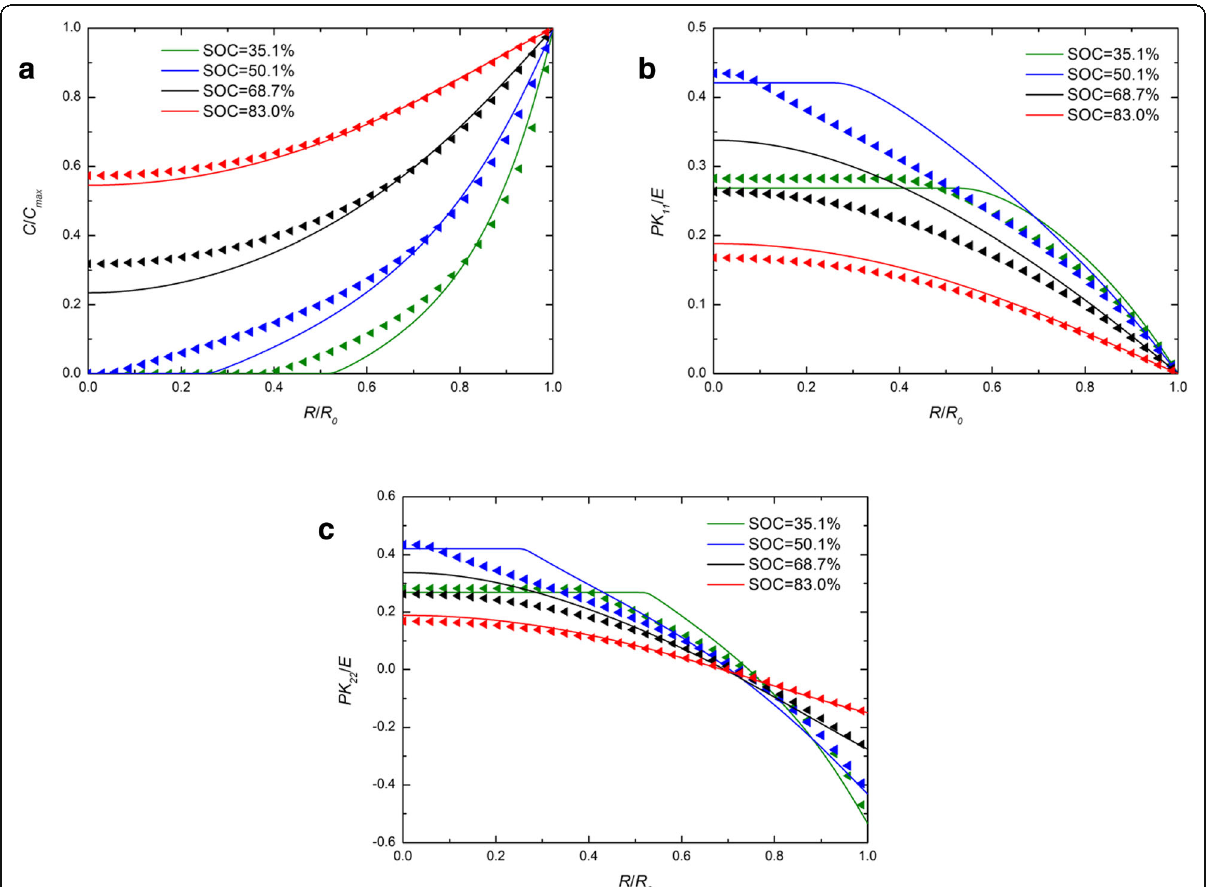
Fig. 2 Spatial distribution of ( a ) the concentration of lithium, ( b ) radial stress, and ( c ) hoop stress in a spherical Si nanoparticle electrode at different SOCs under potentiostatic operation (solid lines represent the results with the traditional expression of chemical potential; triangles lines represent the results with the developed expression of chemical